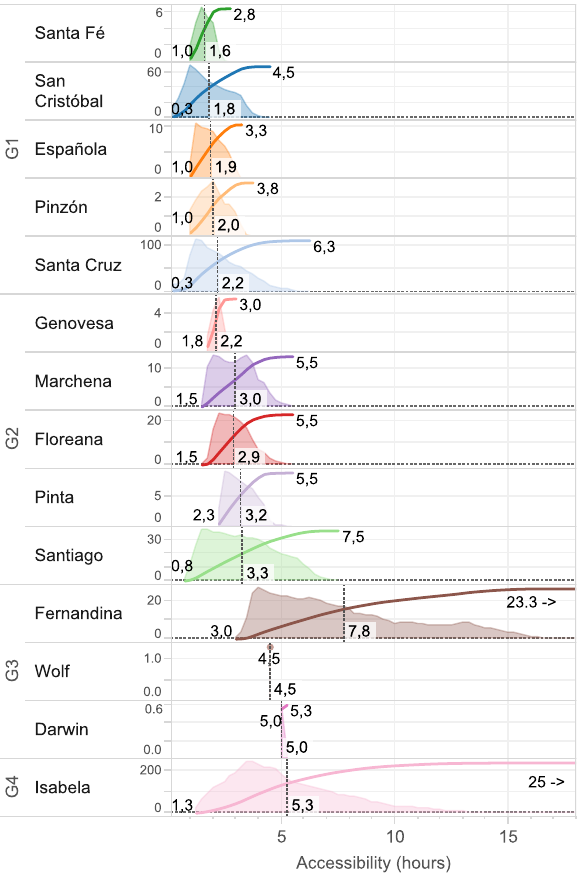
Figure 4: Accessibility statistics for each